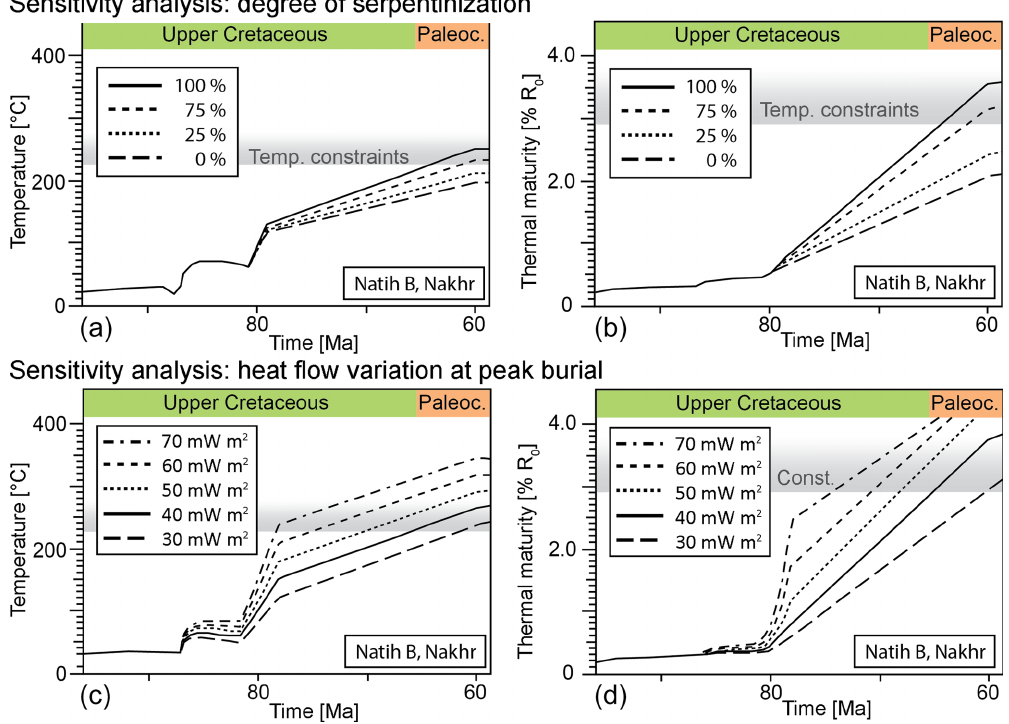
Figure 11. Sensitivity analysis: (a, b) different degrees of serpentinization of the peridotite within the Semail Ophiolite affect the temper- ature (a) and thermal maturity (b) evolution (modeled for Natih B Fm. at Wadi Nakhr). Pure peridotite (0% serpentinization) requires an additional 3km of ophiolite in addition to the 8–10km of the best-fit model to equally match the calibration data; 100% refers to complete serpentinization of the peridotite in the ophiolite. (c, d) The influence of variable heat flow values at peak burial on temperature (a) and thermal maturity (b)